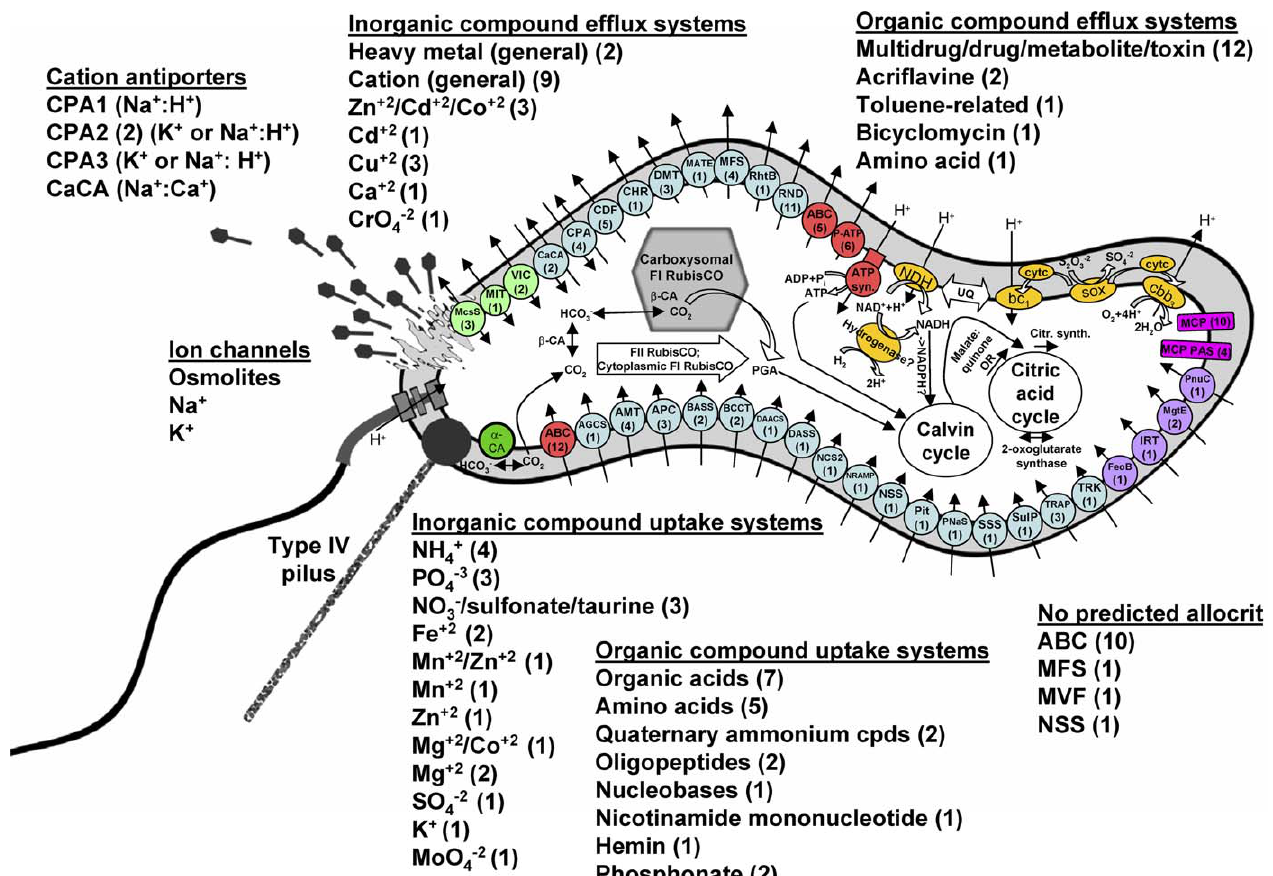
Figure 2. Cell Model for Thiom. crunogena XCL-2, with an Emphasis on Ultrastructure, Transport, Energy, Carbon Metabolism, and Chemotaxis Genes encoding virtually all of the steps for the synthesis of nucleotides and amino acids by canonical pathways are present in the bacterium, but are omitted here for simplicity. Electron transport components are yellow, and abbreviations are as follows: bc 1 , bc 1 complex; cbb 3 , cbb 3 -type cytochrome C oxidase; cytC, cytochrome C; NDH, NADH dehydrogenase; Sox, Sox system; UQ, ubiquinone. MCPs are fuchsia, as are MCPs with PAS domains or PAS folds. Influx and efflux transporter families with representatives in this genome are indicated on the figure, with the number of each type of transporter in parentheses. ATP-dependent transporters are red, secondary transporters are sky blue, ion channels are light green, and unclassified transporters are purple. Abbreviations for transporter families are as follows: ABC, ATP-binding cassette superfamily; AGCS, alanine or glycine:cation symporter family; AMT, ammonium transporter family; APC, amino acid-polyamine-organocation family; ATP syn, ATP synthetase; BASS, bile acid:Na þ symporter family; BCCT, betaine/carnitine/choline transporter family; CaCA, Ca 2 þ :cation antiporter family; CDF, cation diffusion facilitator family; CHR, chromate